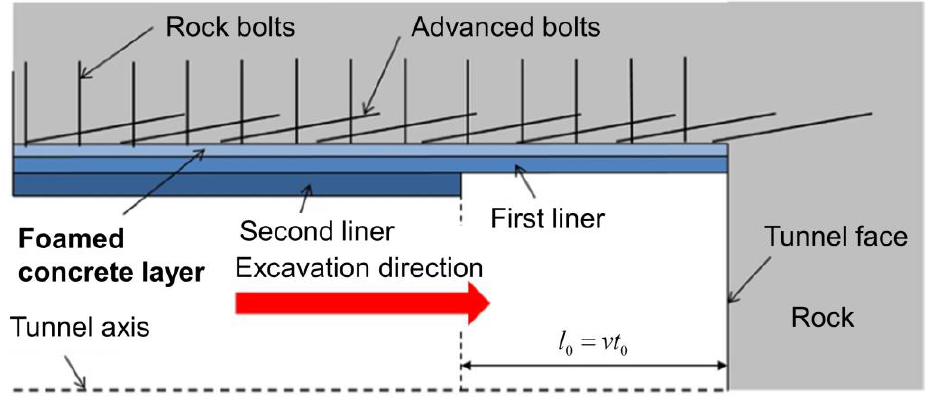
Figure 20. Applications of foamed concrete in tunnel support. [125].